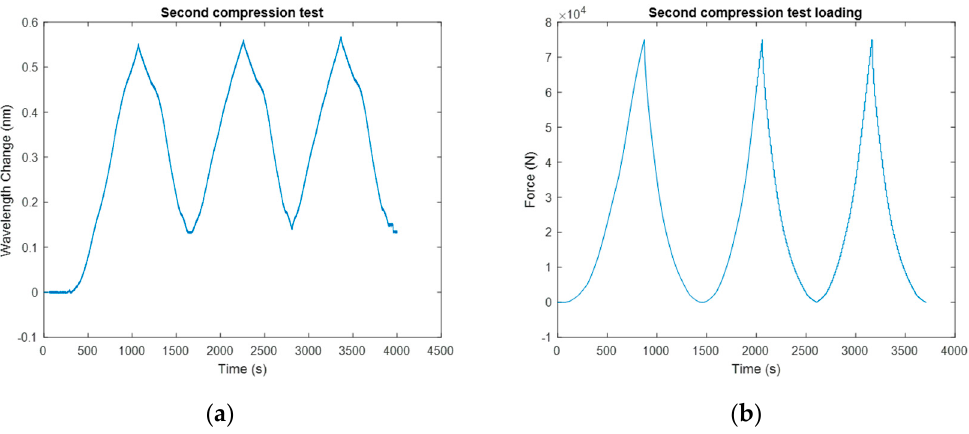
Figure 14. FBG signal for the nondestructive compression test in which the plate was cyclically loaded from 0 to 75 kN: ( a ) Strain; ( b ) Force [46].